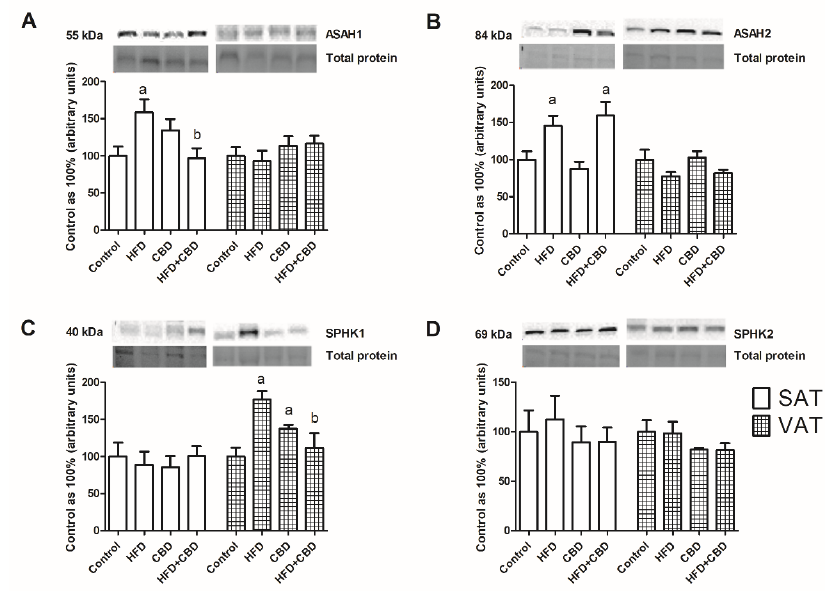
Figure 4. The total expression of proteins from sphingolipid catabolism, e.g., ( A ) acid ceramidase (ASAH1), ( B ) acid ceramidase (ASAH2), ( C ) sphingosine kinase 1 (SPHK1), and ( D ) sphingosine kinase 2 (SPHK2), in the subcutaneous (SAT) and visceral (VAT) adipose tissues of rats fed a standard diet (control) or high-fat diet (HFD) after chronic CBD treatment. The total expression of the above proteins was standardized to the total protein expression, and the control group was set to 100%. The data are expressed as mean values ± SD, n = 6 in each group. a p < 0.05: significant difference: control group vs. experimental group; b p < 0.05: significant difference: HFD vs.